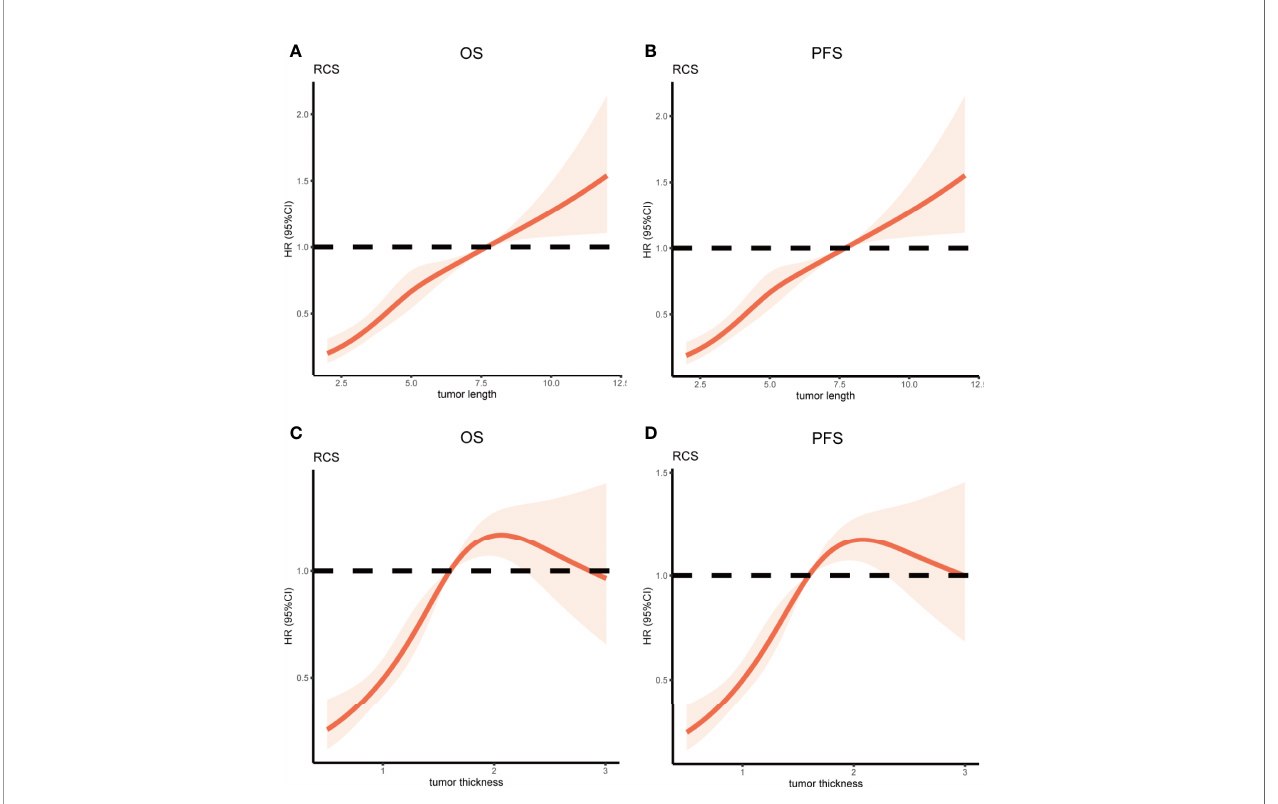
FIGURE 2 | Restricted Cubic Spline analysis was used to classify the association between tumor length, tumor thickness, and survival in ESCC patients. The hazard ratio derived from a Multivariate Cox model is shown on the y-axis. The 95% CI of the adjusted hazard ratio are represented by the shaded area. The 7.7cm and 1.6cm are the reference of tumor length and tumor thickness (HR=1). (A, B) A nonlinear relationship between the tumor length and survival for patients with ESCC. The death hazard of tumor length sharply increased at 7.7cm (p < 0.001 for non-linearity); (C, D) A nonlinear relationship between the tumor thickness and survival for patients with ESCC. The death hazard of tumor thickness sharply increased at 1.6cm (p < 0.001 for non-linearity). ESCC, esophageal squamous cell carcinoma; HR, hazard ratio; CI, con fi dence interval; OS, overall survival; PFS, progression-free